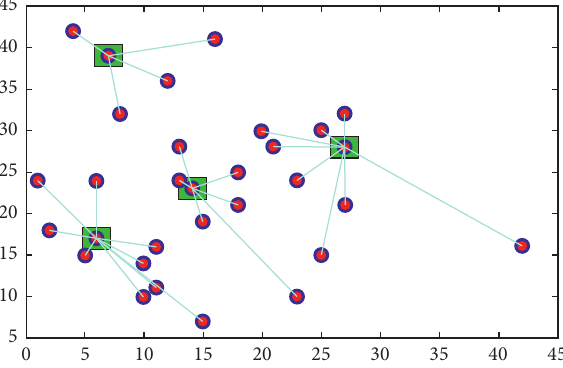
Figure 5: Customer ownership in a static environment.